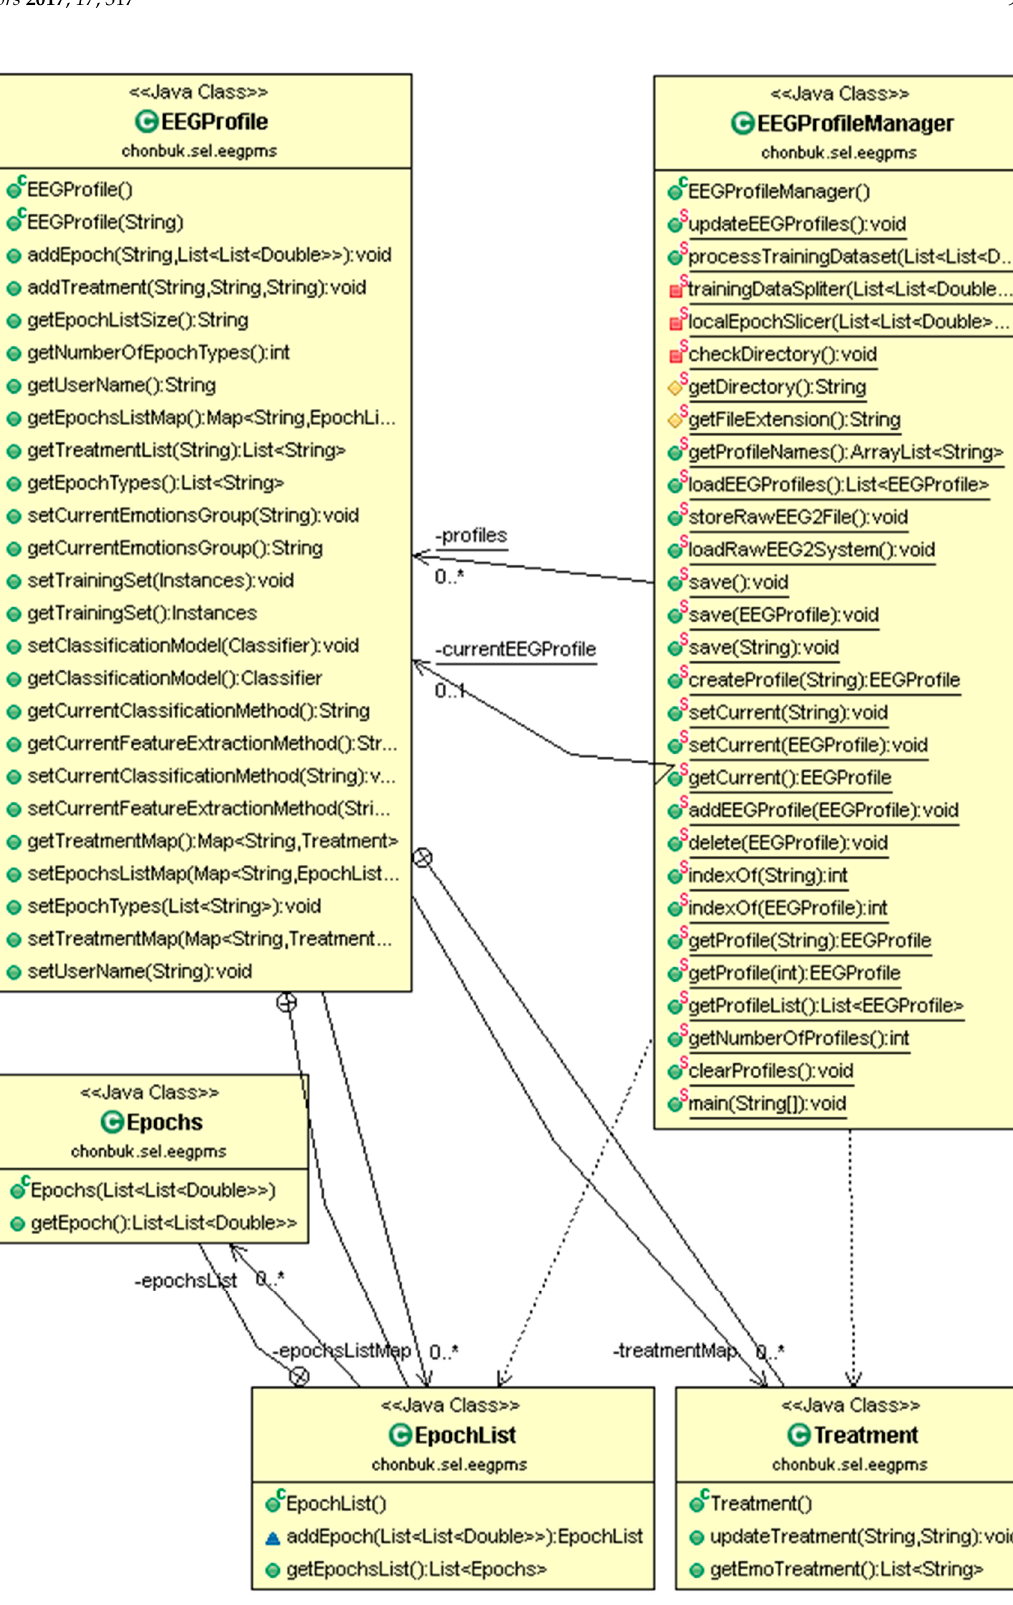
Figure 7. Class diagram for user profile management.